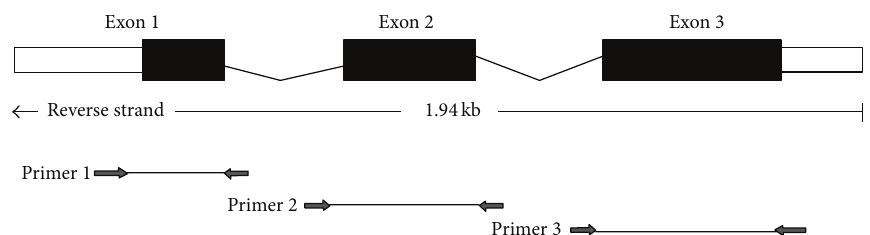
Figure 4: Analysis of human goosecoid ( GSC ) gene mutation in the 3 GSC exons. All 3 exons of the GSC gene were screened in this patient by sequence analysis using the fluorescent dideoxy terminator method and analyzed on an ABI 377 sequencer (Applied Biosystems). Intronic primers flanking each entire exon were designed from human genomic sequence (accession number AL121612) as described previously [9].